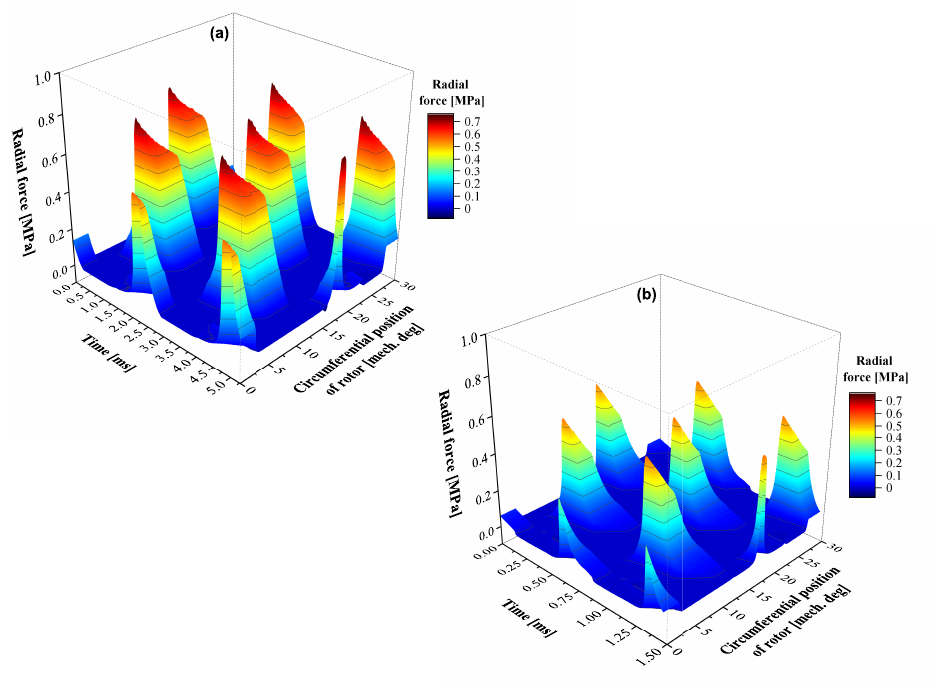
Figure 11. Radial force density of the 36/24 SRM at ( a ) 950 RPM and ( b ) 3400